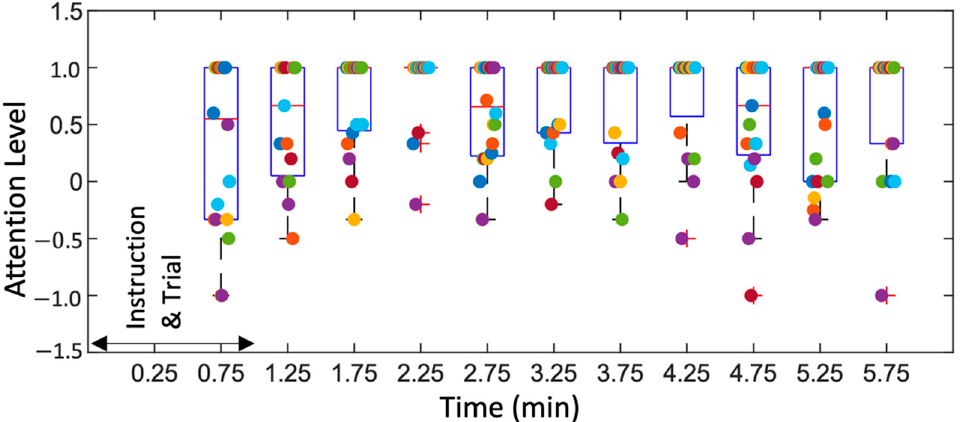
Figure 10. Box plot showing attention levels of participants as the routine progressed. Each partici- pant is indicated by a scatter point in the 30 s time bin.